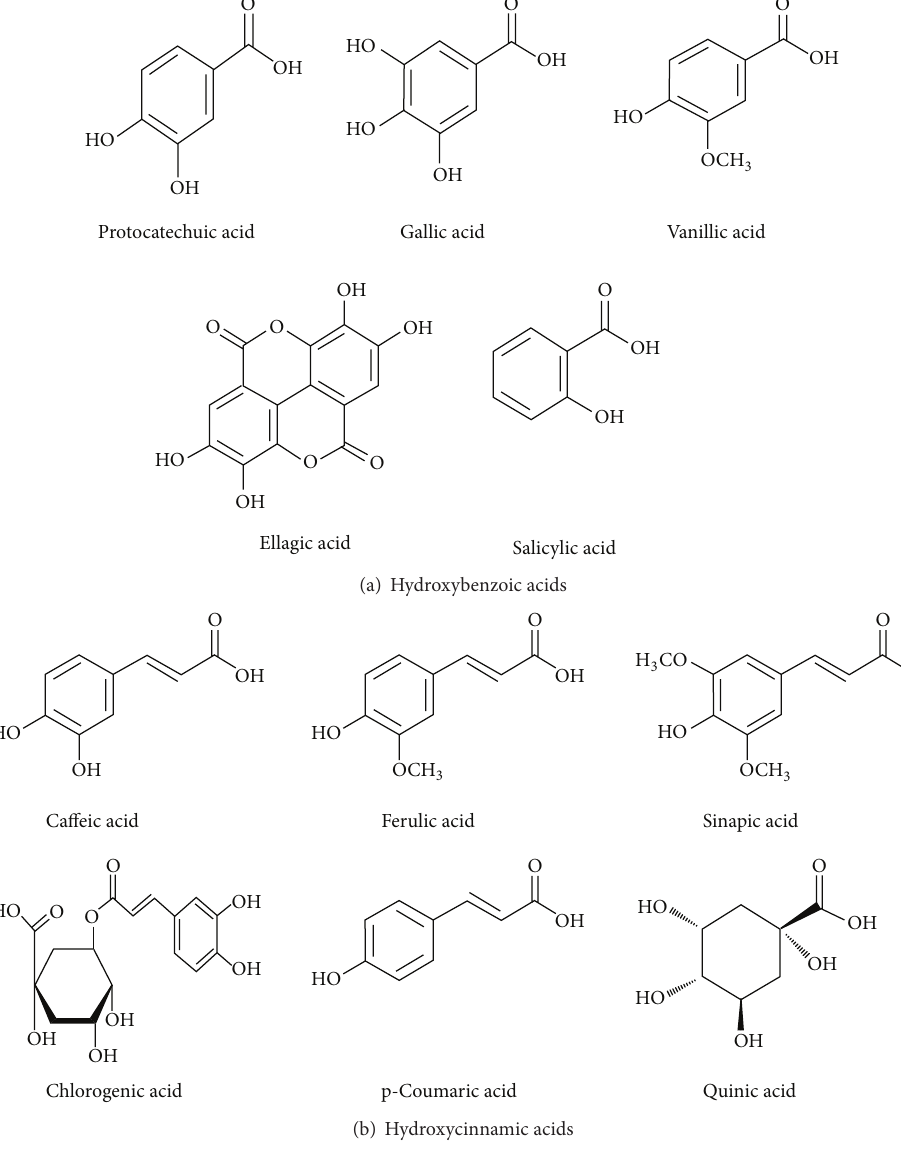
Figure 2: Structural classification of natural PAs discussed in the